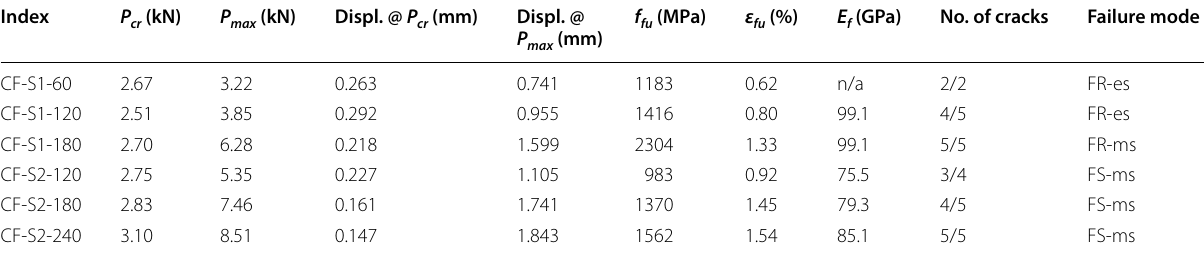
Table 6 Summary of lap-splice test results.